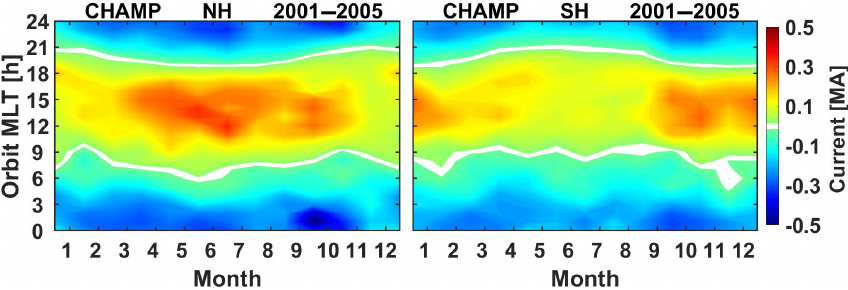
Figure 4. Distribution of mean eastward net currents in local time versus month of year frames separately for the two polar regions. Currents in the noon sector are strongest during the local summer season in the two